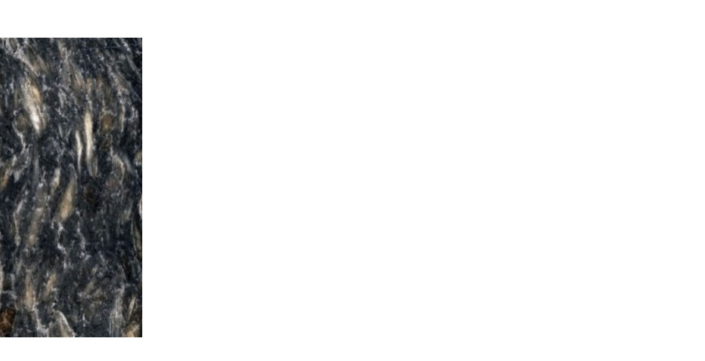
Figure 2. Microscopic structure of wood–plastic composite material—cracks at the interfaces (Nikon Eclipse 80i, Tokyo, Japan) [55].